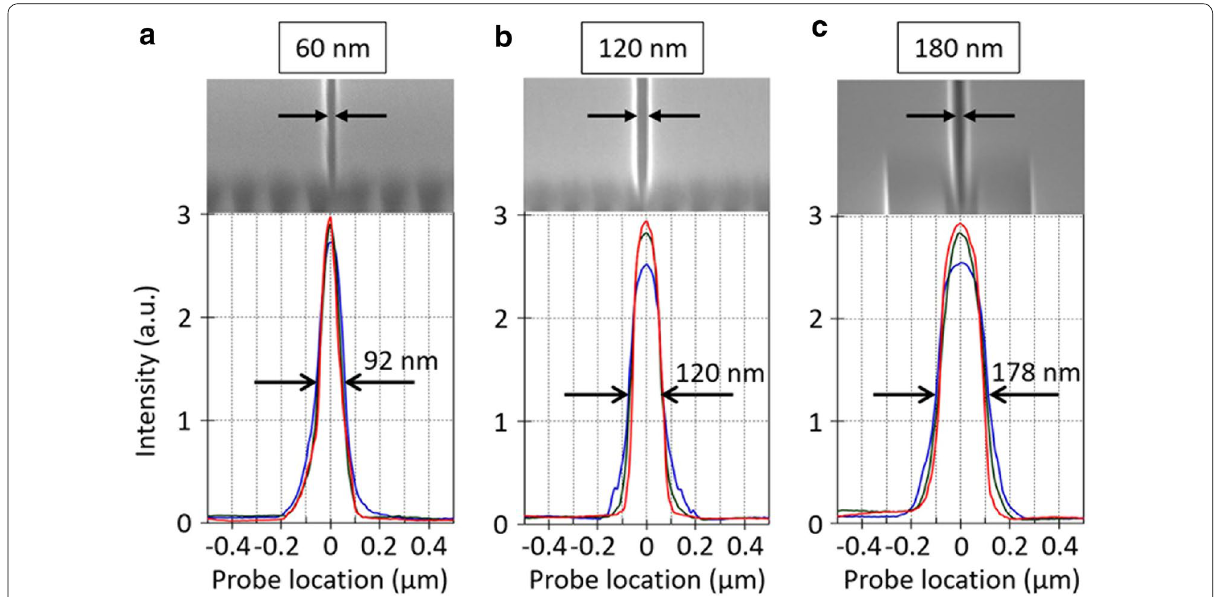
Fig. 4 Spatial resolution of NSOM scanning. A single horizontal nanoslit (slit width of 60 nm, 120 nm, or 180 nm) was formed in a Cr film (65-nm thick): see top panels for SEM images. The NSOM scan profiles at y 0.16 µm (red), 0.31 µm (green), and 0.47 µm (blue) at 633 nm wavelength: see = bottom panels. a 60-nm slit sample showing 92 nm FWHM. b 120-nm slit sample showing 120 nm FWHM. c 180-nm slit sample showing 178 nm